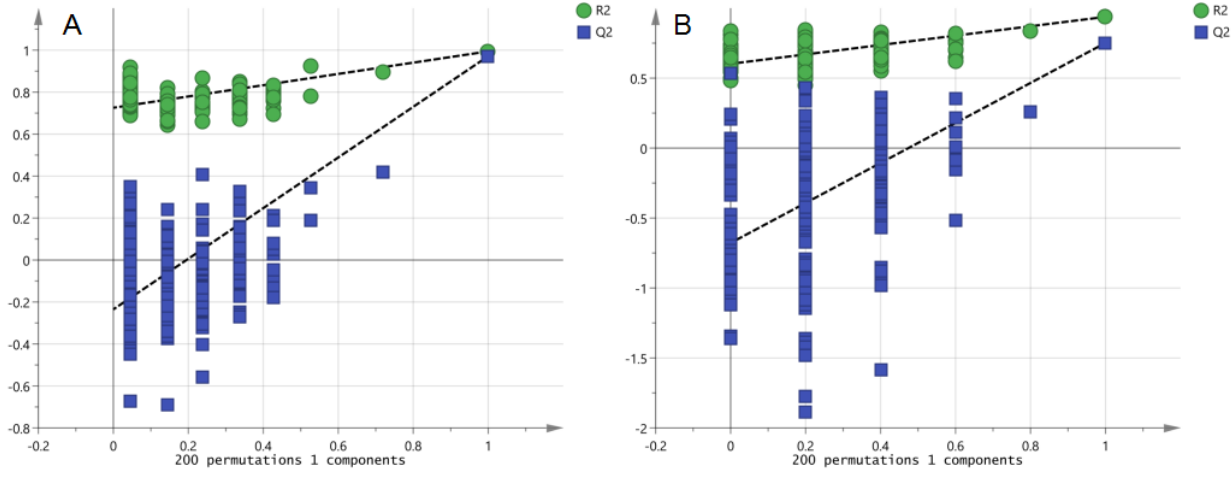
Figure 6. PRT analysis of the T2D model in db/db mice (( A ). NEG, PRT; ( B ). POS, PRT). Table 2. Identification of differential metabolites in mouse serum between normal group and model